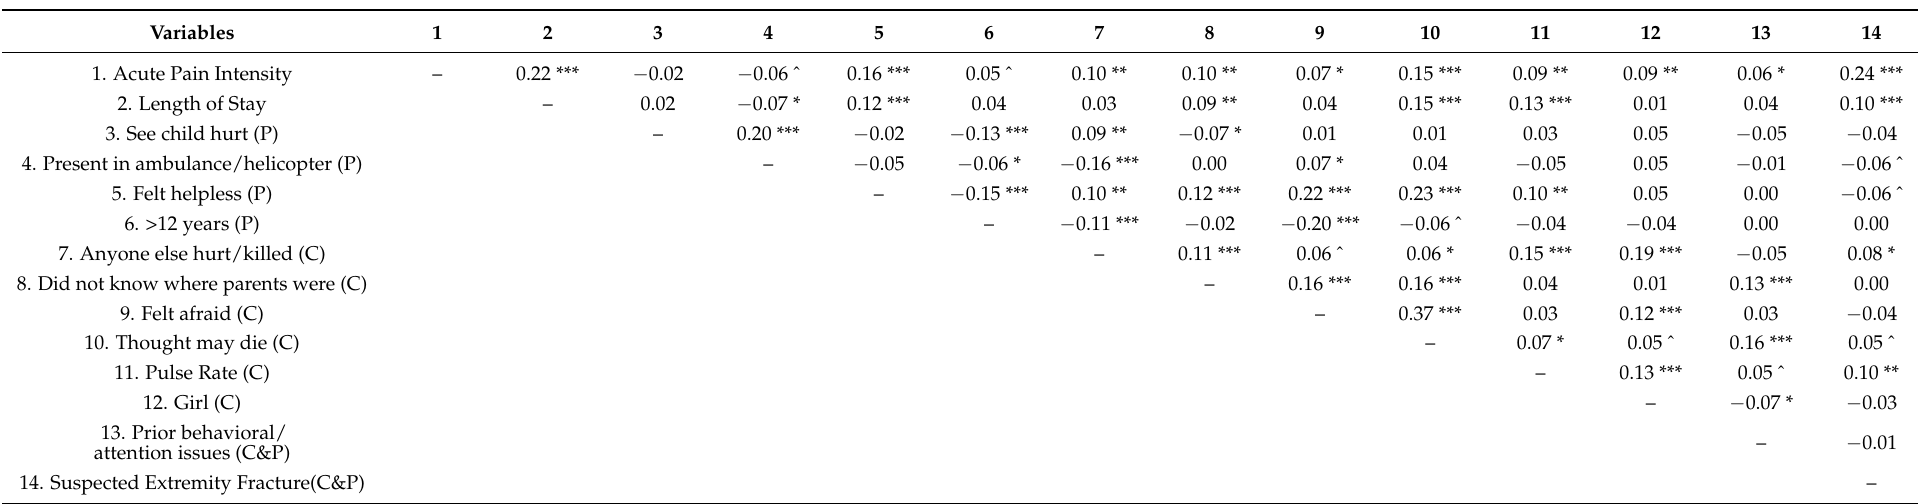
Table 2. Intercorrelations Among the